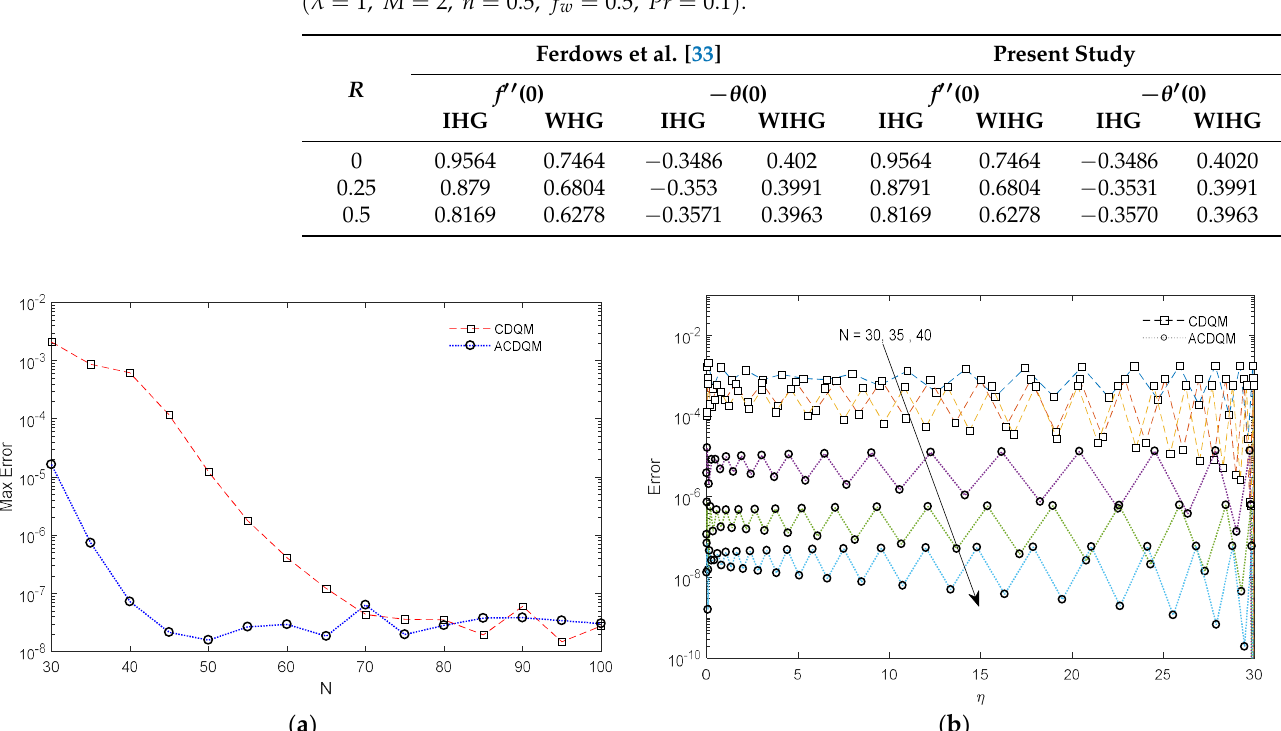
Table 2. Comparison of f (cid:48)(cid:48) ( 0 ) and − θ (cid:48) ( 0 ) for various values of the micropolar parameter R when